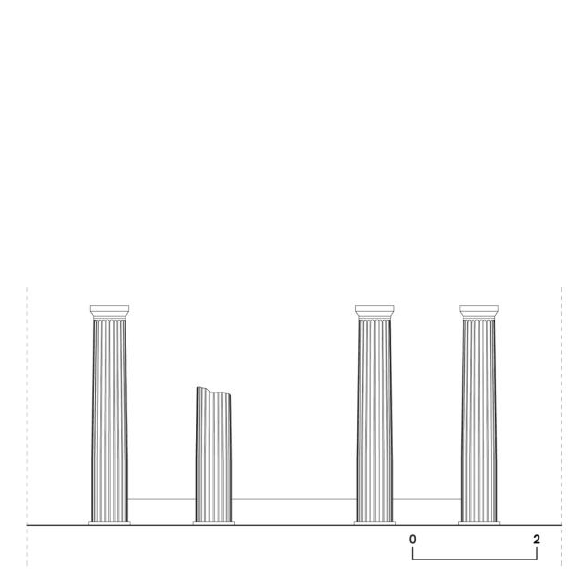
Figure 20. The Tomb of Persephores in Verghina. Survey.